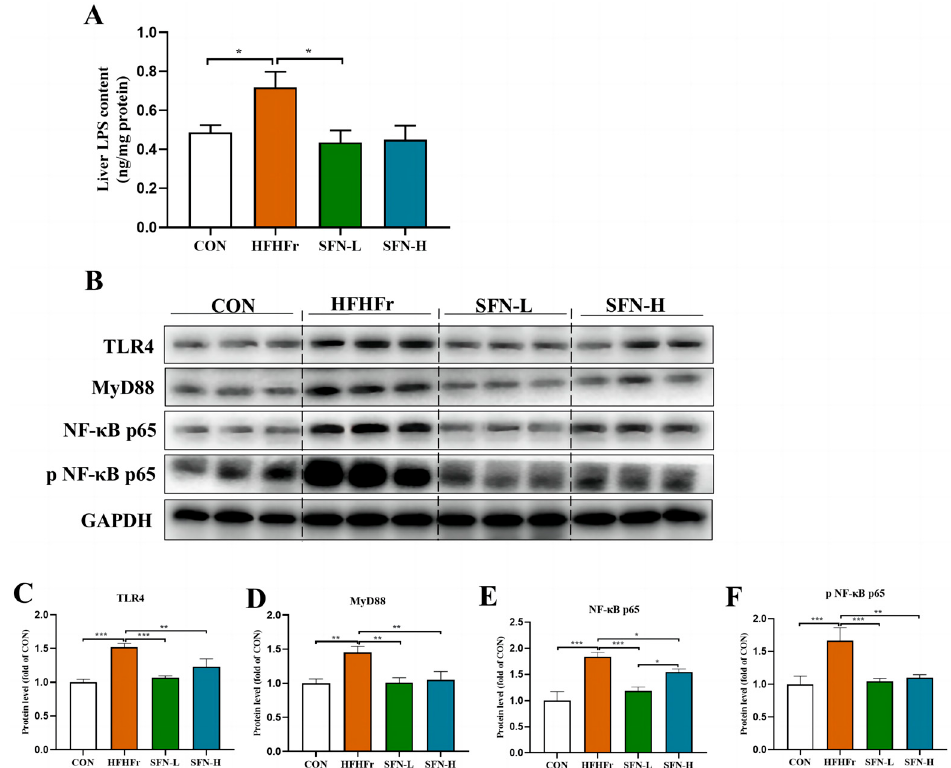
Figure 5. SFN improves hepatic inflammation by inhibiting the TLR4/MyD88/NF- κ B signaling pathway in HFHFr mice. ( A ) Levels of LPS in the liver ( n = 6). ( B – F ) The protein expression of TLR4, MyD88, NF– κ B p65, and phosphorylation of NF– κ B p65 in the liver were detected by Western blot ( n = 3). Data are shown as mean ± SEM. * p < 0.05, ** p < 0.01, *** p < 0.001 compared with